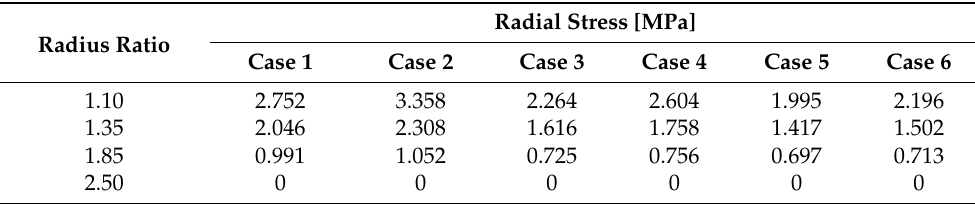
Figure 4. ( a ) Winding tension profile (constant, linear, and parabolic); ( b ) estimated radial stress; ( c ) the measured radial stress with respect to the radius ratio; and ( d ) the measured radial stress for case 2 with respect to the aging time. Table 3. Measured radial stress depending on the taper tension profile and aging time.